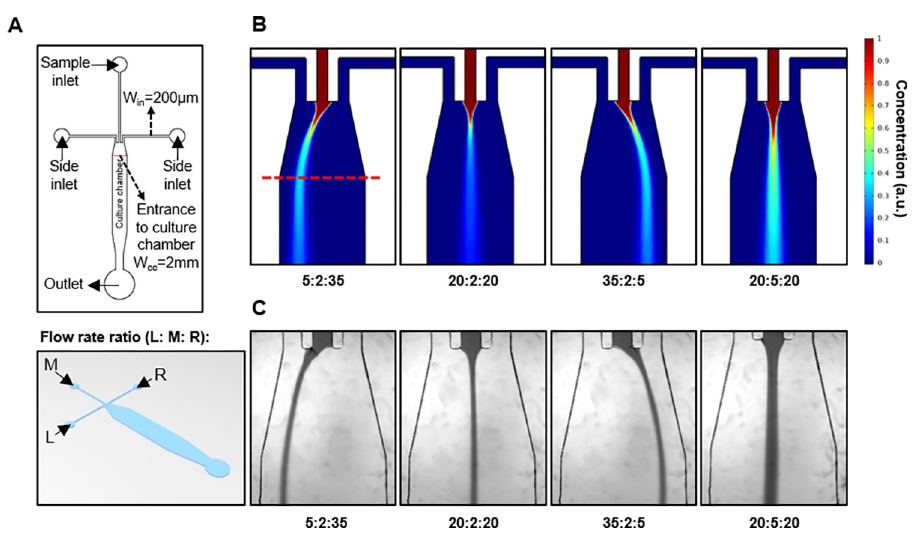
Fig 1. Design, simulation and experimental test of hydrodynamic focusing and shifting microfluidics (HFSM). A Design of HFSM device. B Simulation and C experimental testing of sample fluid in the HFSM device using a brightfield microscope and food dye solution. The red dotted lines in A and B (left) indicate the entrance to the cell culture